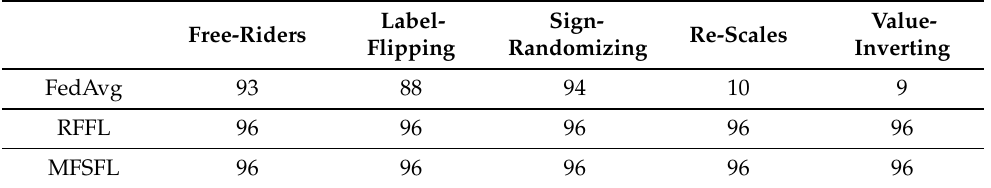
Table 4. Maximum accuracy (%) of five attack modes for MNIST under UNI with 10 G_P and additional 110% M_P.